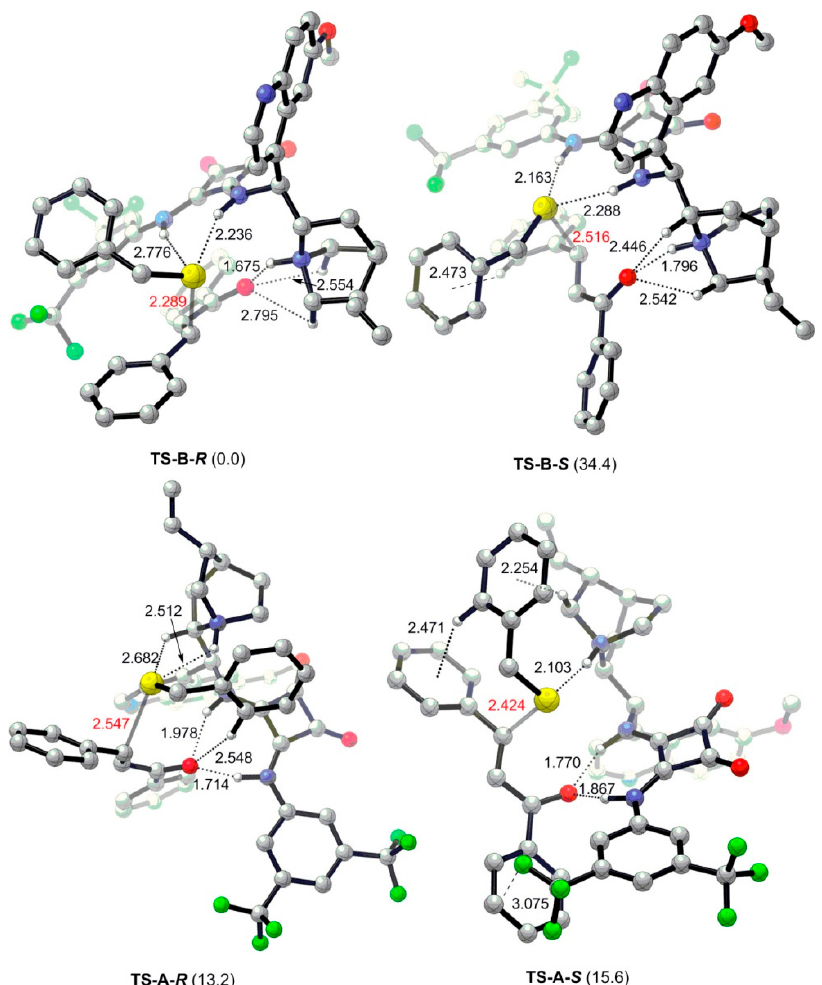
Figure 25. C–S bond-forming transition states for the sulfa-Michael reaction between benzyl thiol and chalcone in modes A and B. Relative Gibbs energies (in kJ/mol) are given in parentheses. Intermolecular distances are given in Å. Nonessential hydrogen atoms are omitted for clarity. Reprinted and adapted from Guo, J.; Wong, M.W. J. Org. Chem . 2017 , 82 , 4362–4368, the Journal of Organic Chemistry with permission from the American Chemical Society (Copyright 2017) [57].